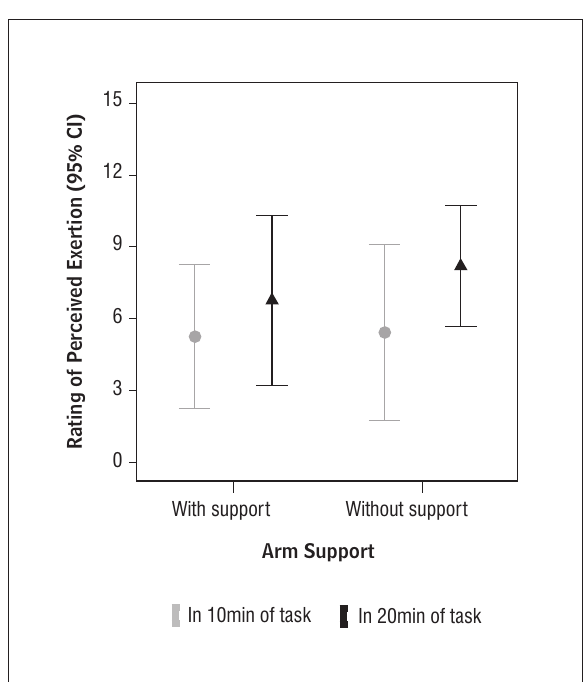
Figure 3 - Error bar (95 % CI) Note: Ratings of perceived exertion referred by subjects during both conditions (with and without arm support). * Signi fi cant dif- ference between 10 minutes and 20 minutes in the condition without arm support ( P = 0.03). Source: Research